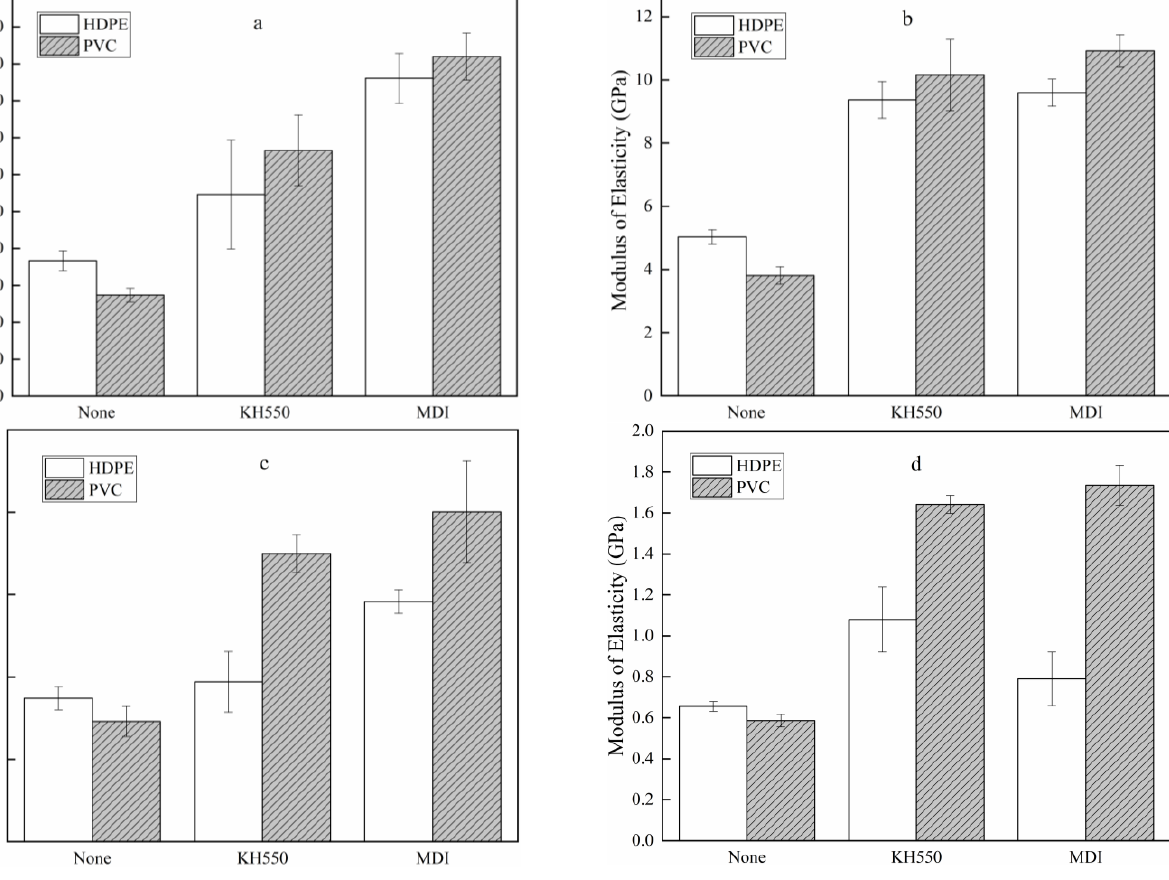
Figure 6. ( a ) MOR in the parallel direction, ( b ) MOE in the parallel direction, ( c ) MOR in the vertical direction, and ( d ) MOE in the vertical direction of OSPC.